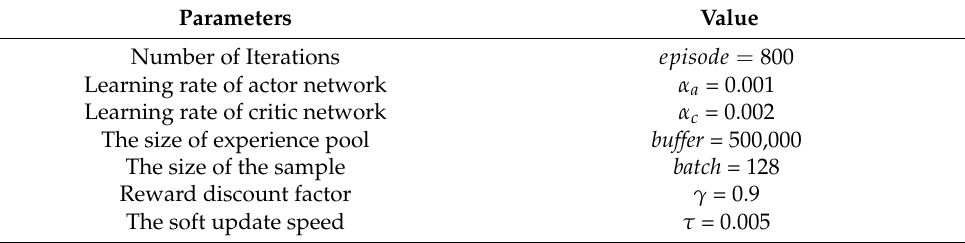
Table 2. Neural network hyperparameter